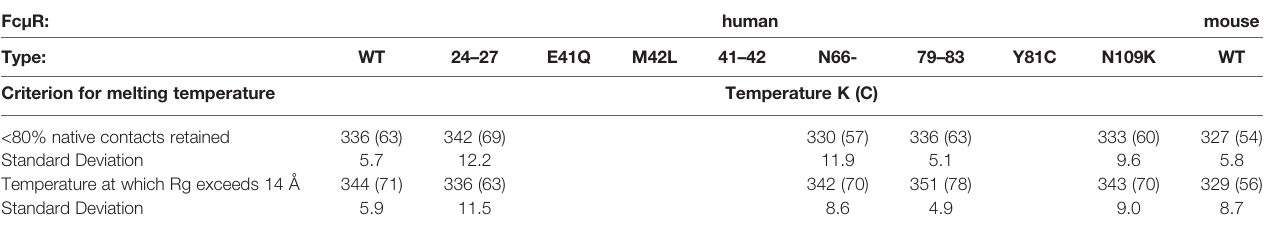
TABLE 1 | Predicted melting temperatures for FcµR lg-like domains of human WT or mutant and of mouse WT. FcµR: human mouse